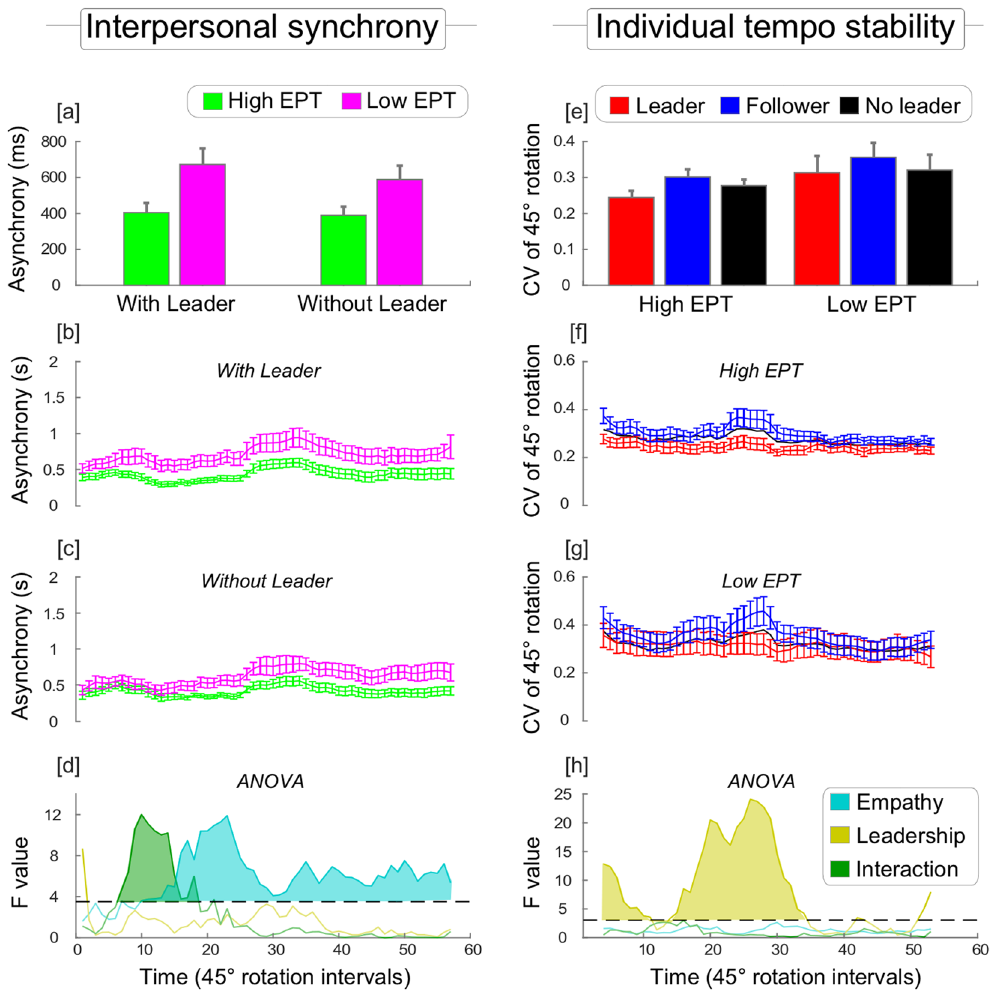
Figure 2. Interpersonal synchrony and individual tempo stability. Left ( a – d ): Interpersonal synchronization accuracy expressed in terms of asynchronies (i.e. the smaller the value, the higher the synchronization accuracy). Right ( e – h ): Individual tempo stability expressed in terms of the coefficient of variation of participants’ movements (i.e. the smaller the value, the more stable and predictable the performed tempo). The top row ( a , e ) displays measures averaged across all time points (each indexing 45° rotations of the E-music box). The second and the third rows display measures for each time point. The fourth row display series of F-statistic values obtained after running an ANOVA for each time point (the dashed line indexes significance threshold of each single test, while the shadowed areas indicate significance following correction for multiple comparison using the cluster-based permutation test). The results from the ANOVAs conducted on the averaged measures (displayed in the top row) are reported in the results section. Bars represent 1 standard error of the